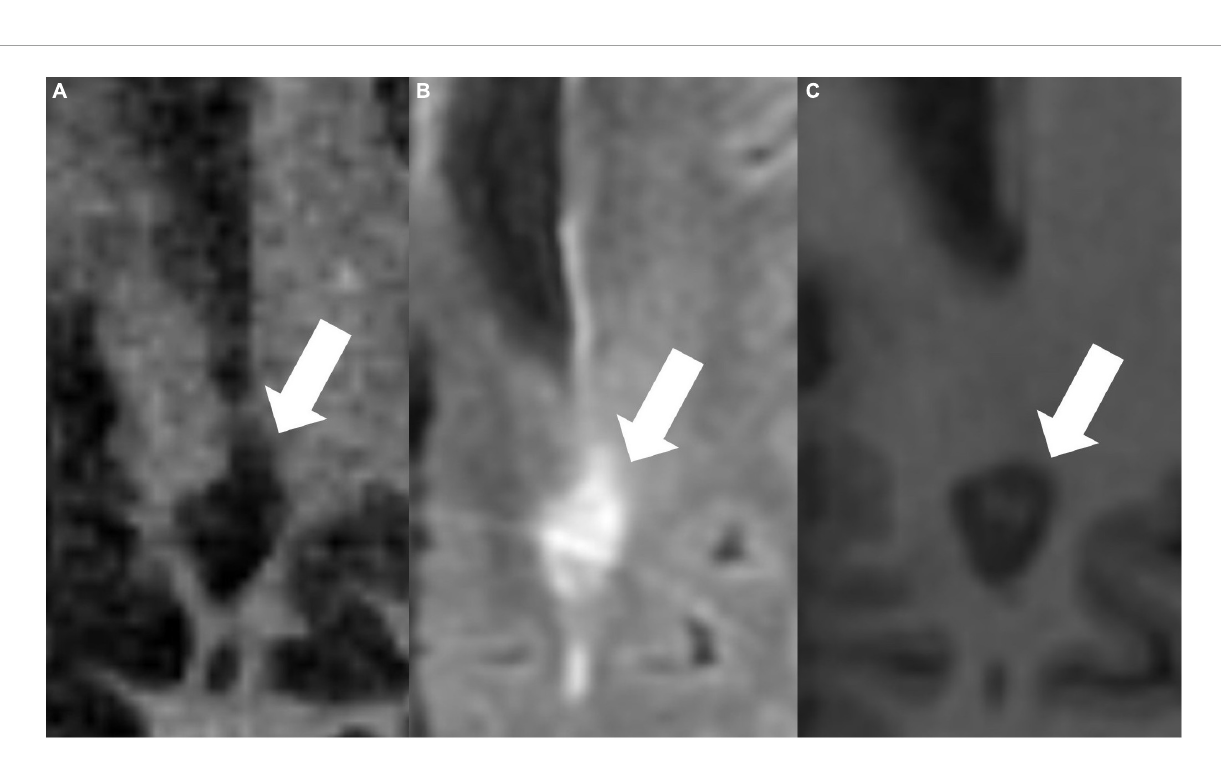
FIGURE4 The same periventricular MS lesion (white arrows) is shown on IR-UTE (A) , FLAIR (B) , and MPRAGE (C) sequences,